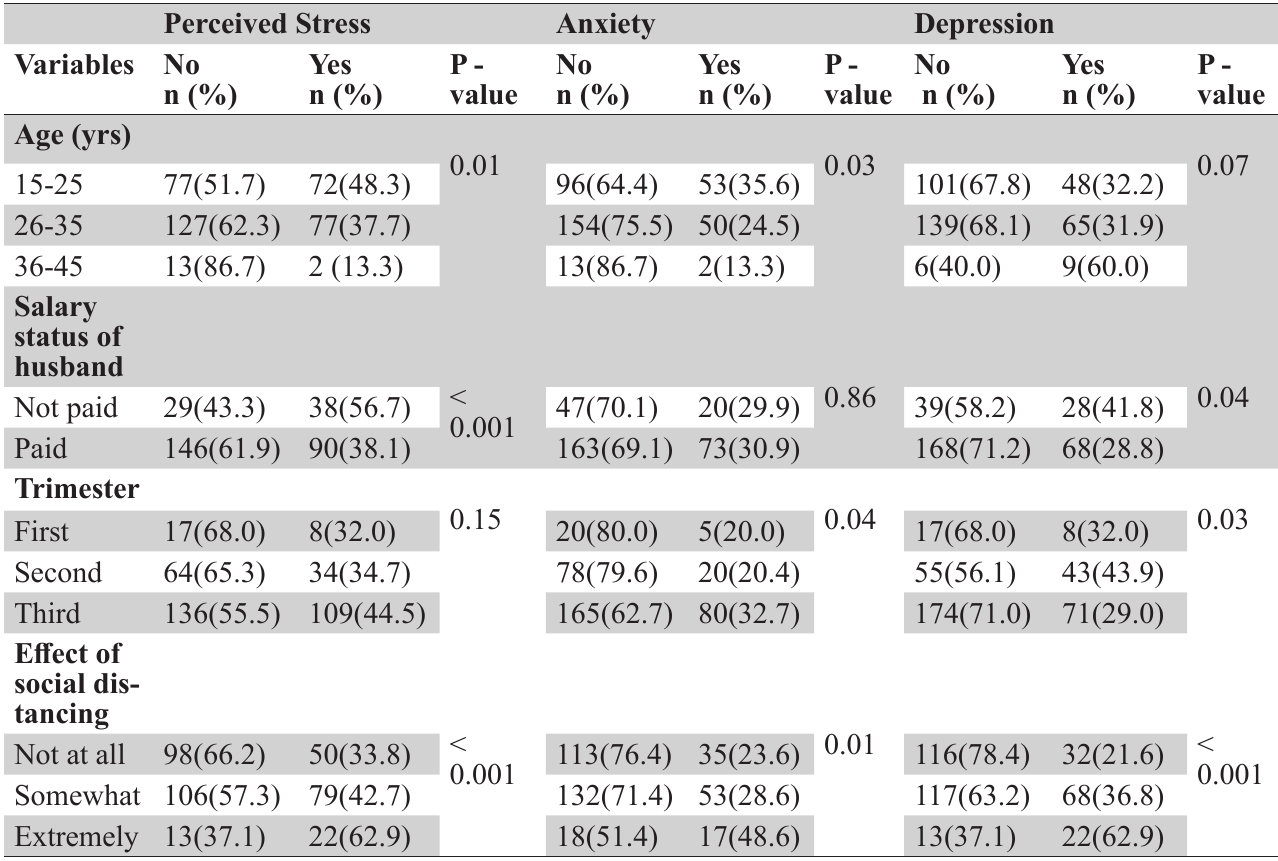
Table 4. Association of perceived stress, anxiety and depression with selected variables. Perceived